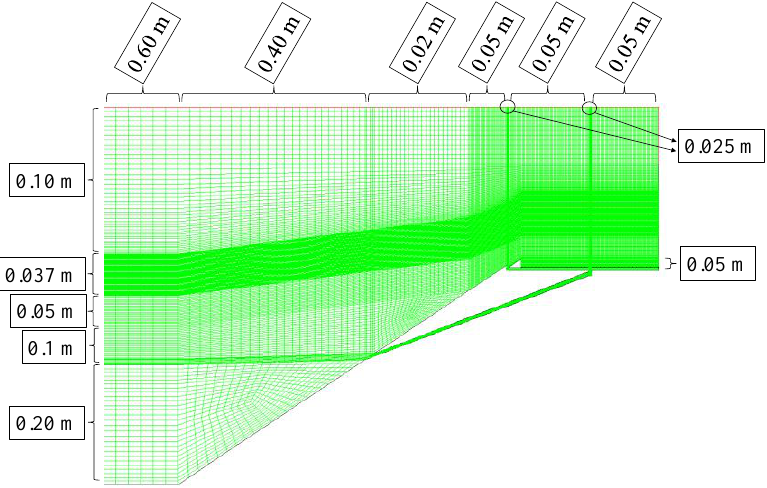
Figure 11. Discretization of the computational domain with the mesh 3, having nearly 182,000 finite volumes.